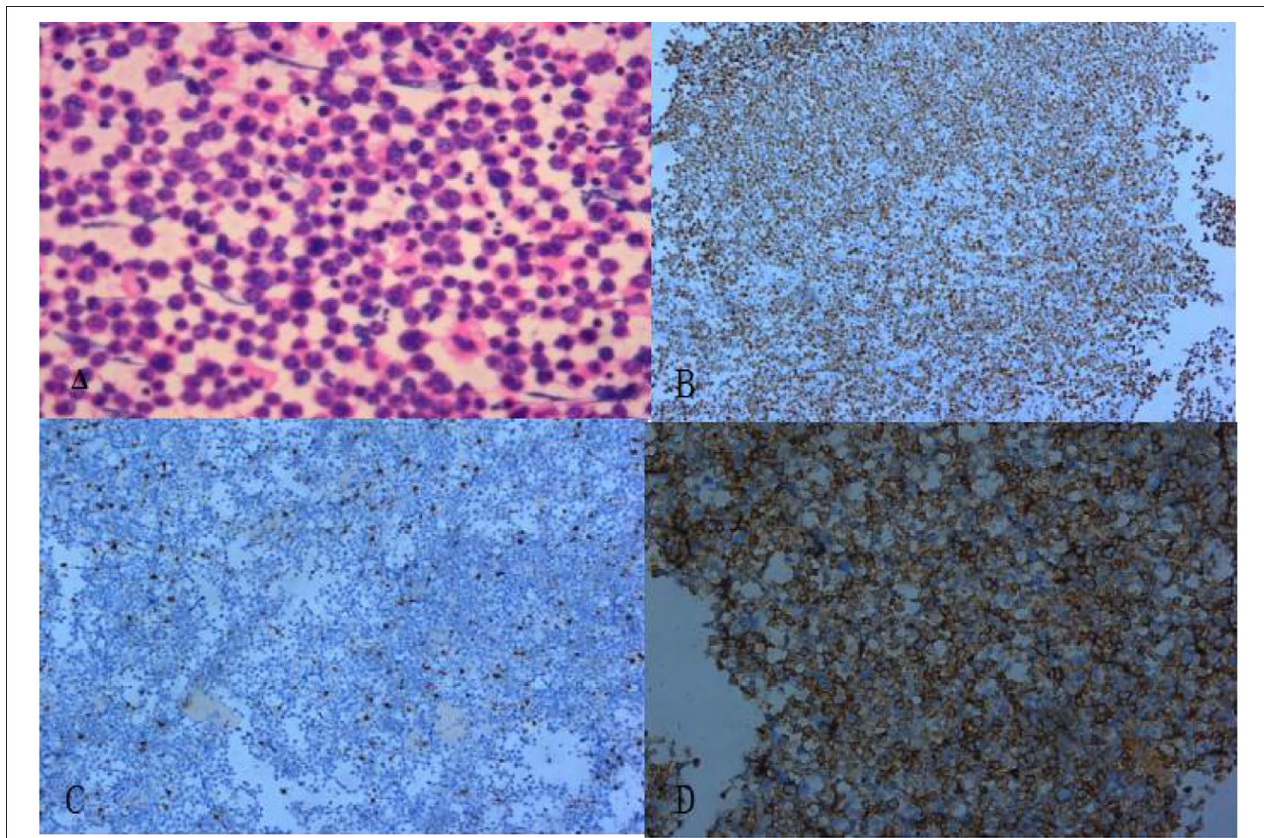
FIGURE 5 | The pathological section revealed diffuse enlargement of lymphocytes. (A) Hematoxylin and eosin staining ( × 200). (B) Ki-67 markers ( + ) ( × 100). (C) CD3 markers (–) ( × 100). (D) CD20 markers ( + ) ( ×